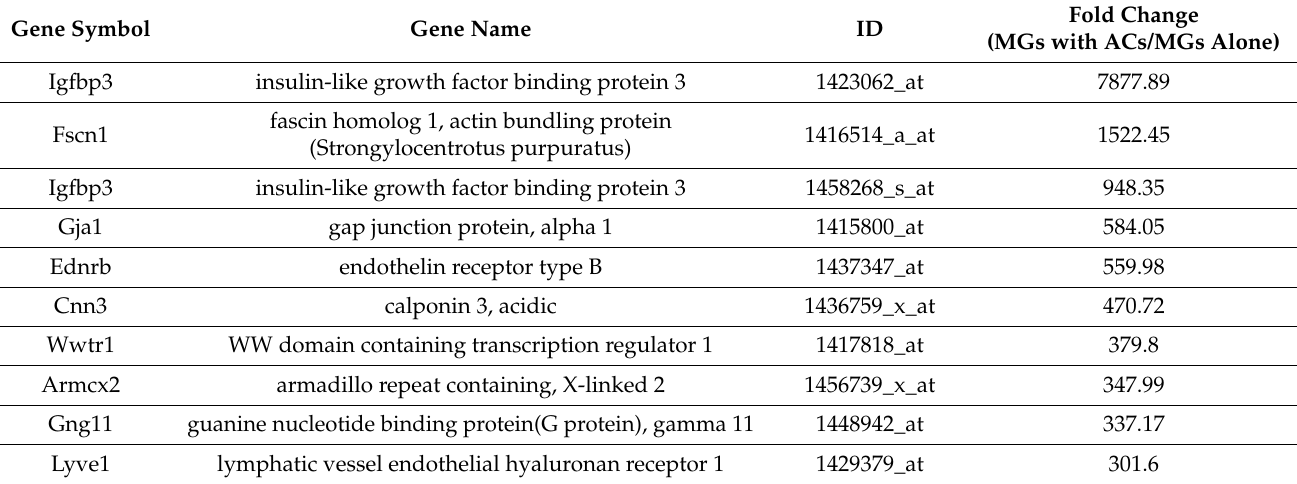
Table 4. List of top 10 highly expressed genes in MGs with ECs compared with MGs